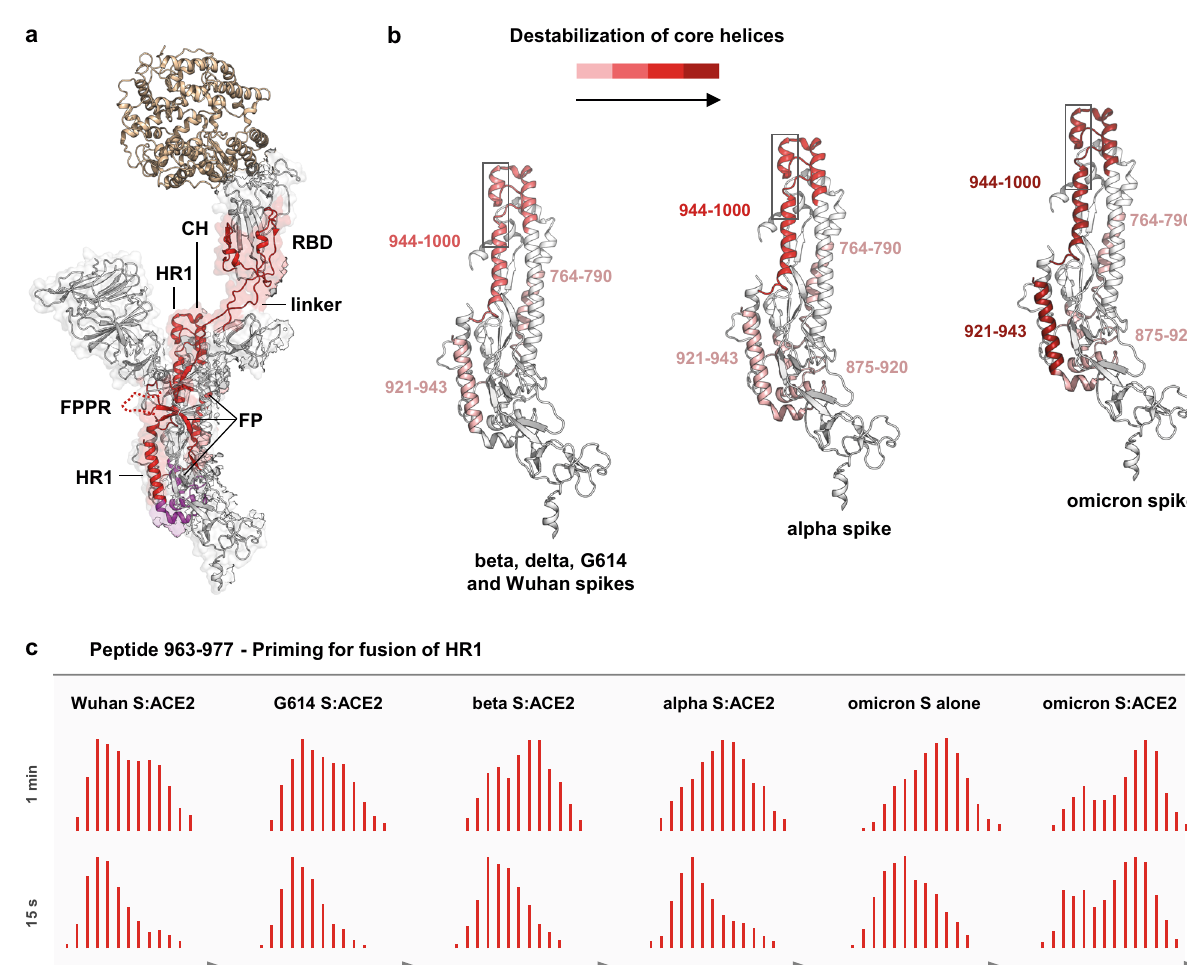
Fig. 6 | Spike priming for fusion. a Regions manifesting increased HDX in spikes bound to ACE2 are superimposed and coloured in red on a single protomer of the structure of D614 spike with one RBD bound (PDB: 7a95 14 ); regions with increased HDX only in spike of alpha and omicron variants bound to ACE2 are coloured in magenta. b The magnitudeofthe destabilizationof the core helices isrepresented by differential colouring (red scale) for the various spike trimers. The HR1 region